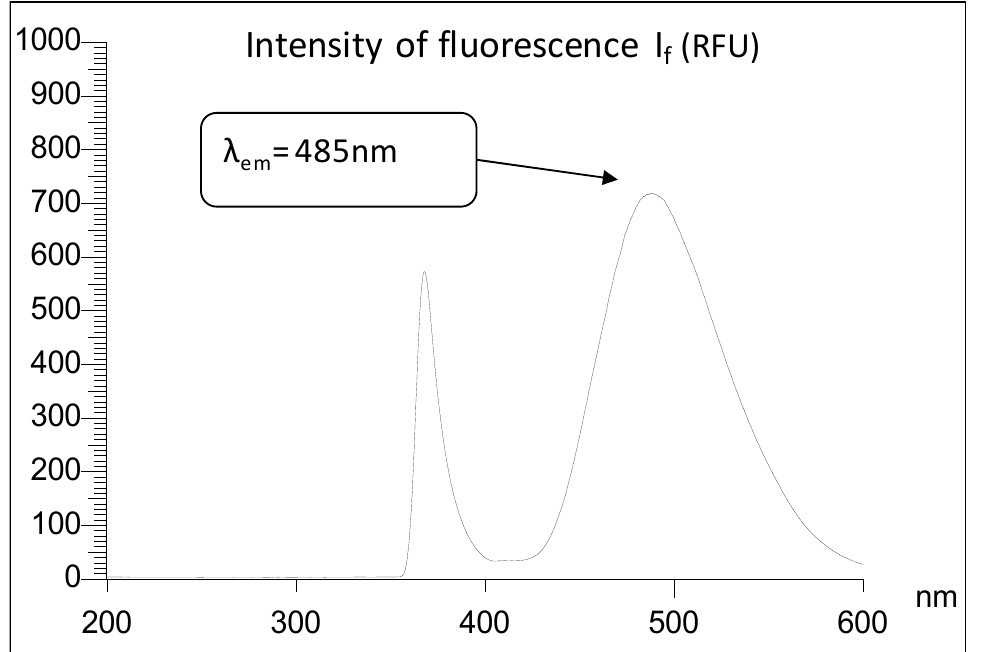
Figure 5. Three-dimensional spectrum of 3-aminoflavone in methanol. Intensity of fluorescence emission I f in RFU (relative fluorescence unit). Instrument parameters. Measurement type: 3D scan; data mode: Fluorescence; EX (Excitation) sampling interval: 3.0 nm; EM (Emission) sampling interval: 3.0 nm; scan speed: 1200 nm/min; EX slit: 5.0 nm; EM slit: 5.0 nm; PMT (Photomultiplier Tube) voltage: 700 V; sensitivity: 1; threshold: 1.0.